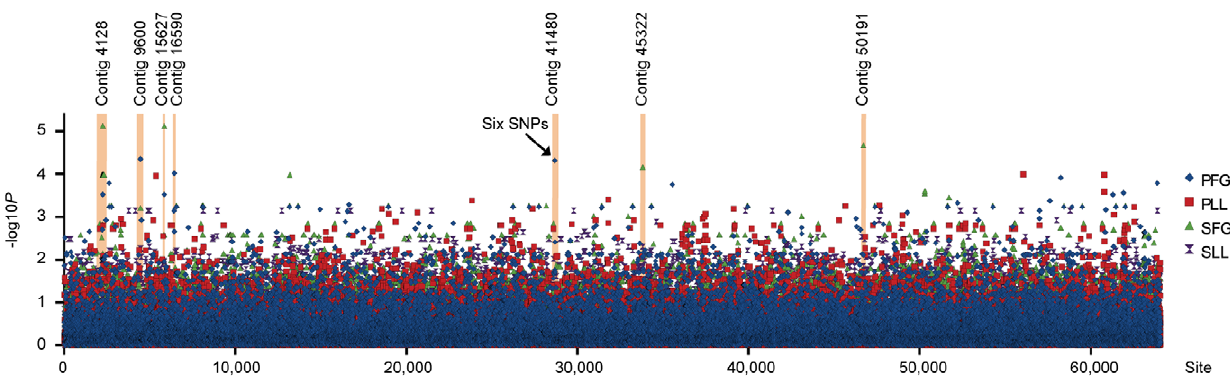
Figure 1. Overview of p -values ( 2 log10 scale) for SNP associations to Heterobasidion virulence in spruce and pine. The p -values are plotted against the site number from the SNP extraction. The contigs with significant SNPs are indicated with orange lines. Abbreviations: PFG, fungal growth in pine sapwood; PLL, lesion length in pine; SFG, fungal growth in spruce sapwood; SLL, lesion length in spruce. doi:10.1371/journal.pone.0053525.g001 PLOS ONE |